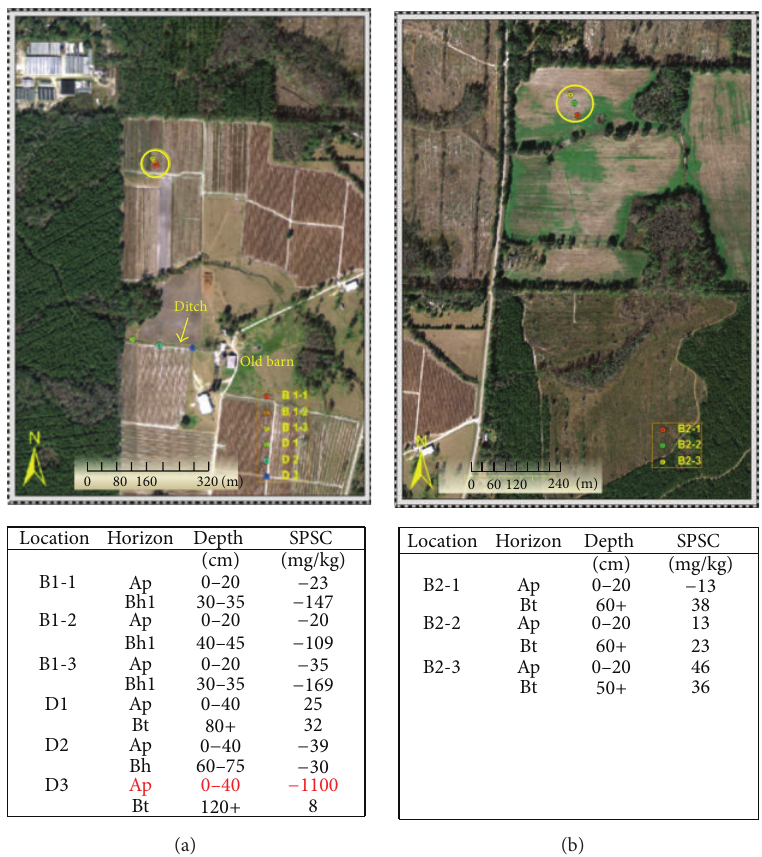
Figure 3: Sites B1 (a) and B2 (b) of a blueberry farm are operated by the same landowner. Random soil samples were collected from Site B1 (B1-1, B1-2, and B1-3) (as clustered in the NW corner of the field, away from the barn area, within a radius of ∼ 20m) and Site B2 (B2-1, B2-2, and B2-3) (as clustered in the N-central part of the field, within a radius of ∼ 30 m). Samples were also collected across a ditch, D1, D2, and D3 at Site B1 with D1 closest to the forested area and D3 closest to the old barn. Soils were collected and analyzed by S. Haile, D. Chakraborty, and J.